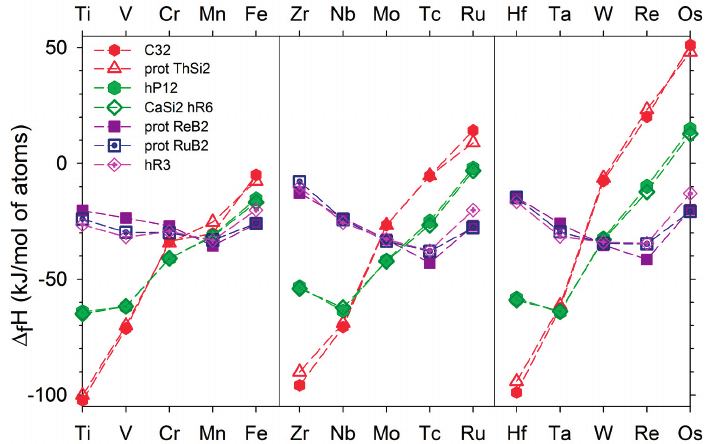
Figure 1. Enthalpies of formation of the TMB 2 compounds in the hP3 (AlB 2 -type), tI12 ( α -ThSi 2 -type), hP12 (WB 2 -type), hR6 (MoB 2 -type), hP6 (ReB 2 -type), oP6 (RuB 2 -type), and hR3 (CaSi 2 -type)